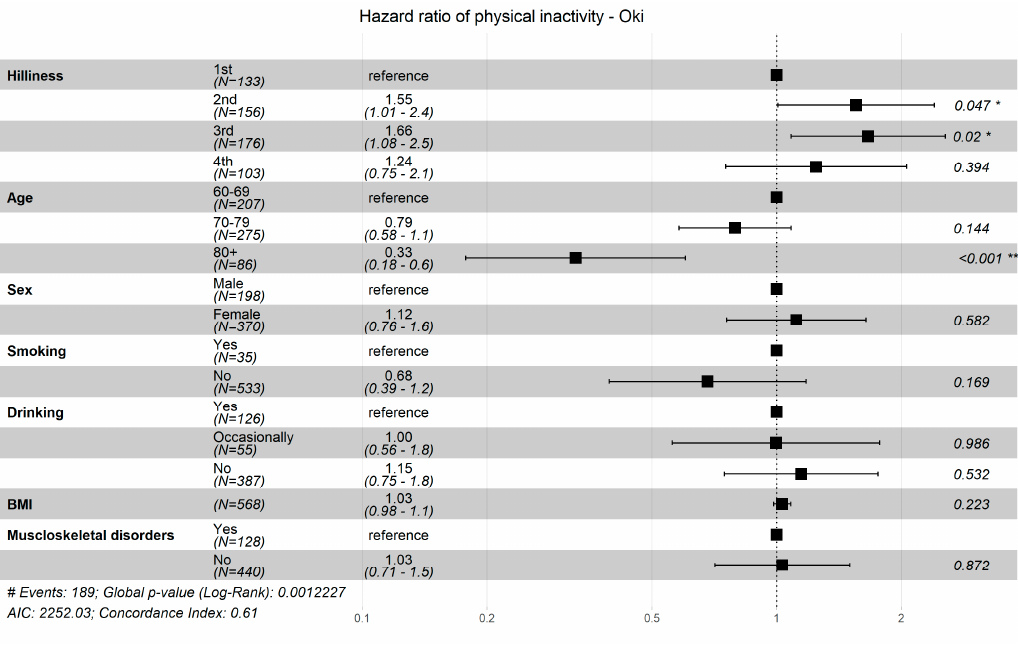
Figure 2. Hazard ratio of physical inactivity by quartile category of hilliness in Okinoshima. Quartile 1 (1st) = 3.41, 6.98 degree(d); Quartile 2 (2nd) = 6.98, 10.1 d; Quartile 3 (3rd) = 10.1, 13.7 d; Quartile 4 (4th) = 13.7, 26.2 d.